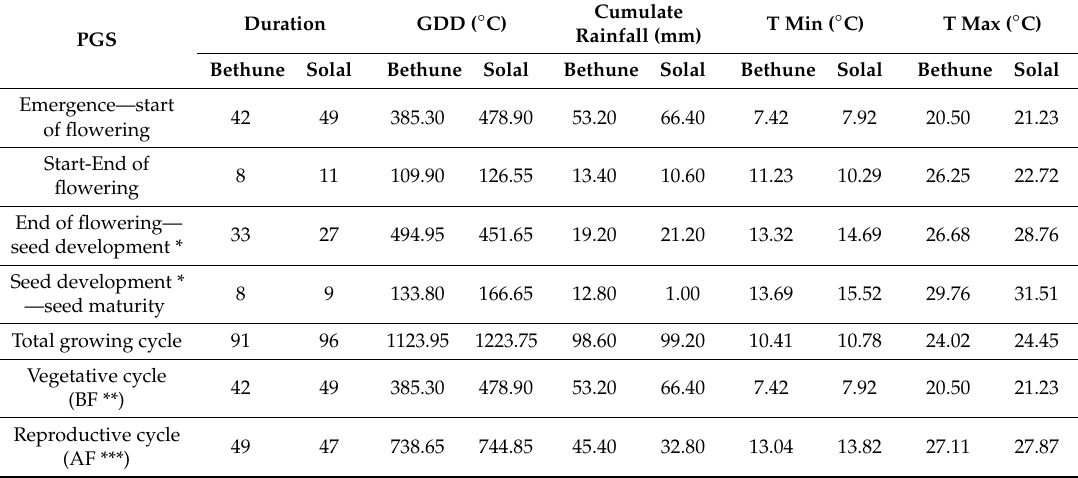
Table 1. Main phenological growth stages (PGS) of the two linseed varieties (Bethune and Solal) expressed as duration days, growing degree days (GDD) and precipitation (rainfall) accumulated for each phenological period. Values are expressed as means of three observations. Minimum and maximum temperature resulted from mean values referred to each phenological